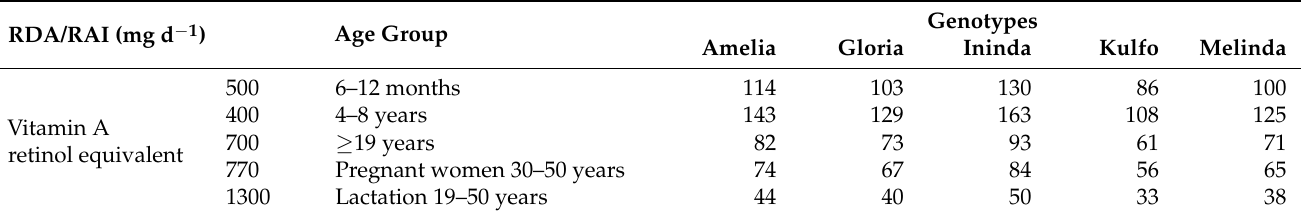
Table 7. Percentage of recommended dietary allowance/recommended adequate intake for vitamin A supplied by the studied OFSP